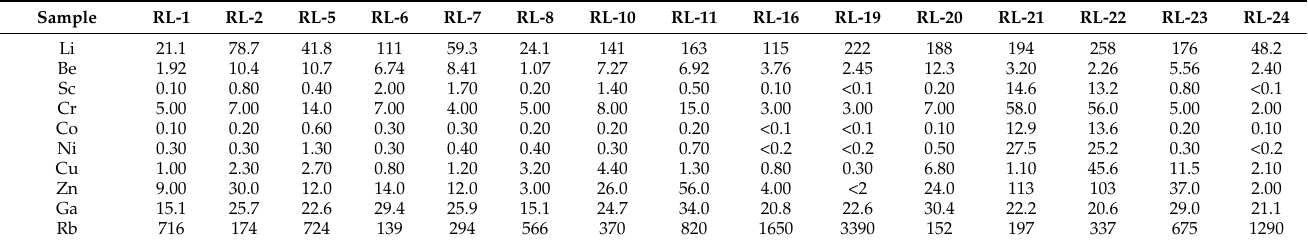
Table 2. Trace elements composition for the pegmatite from Renli Nb-Ta deposit